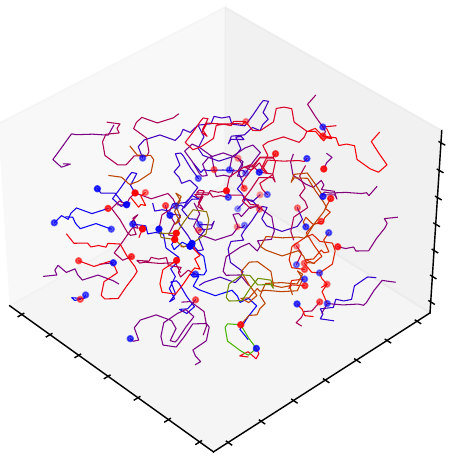
Figure 3 . Sample monopole distribution with strings connecting them. Some of the strings are in the form of closed loops.